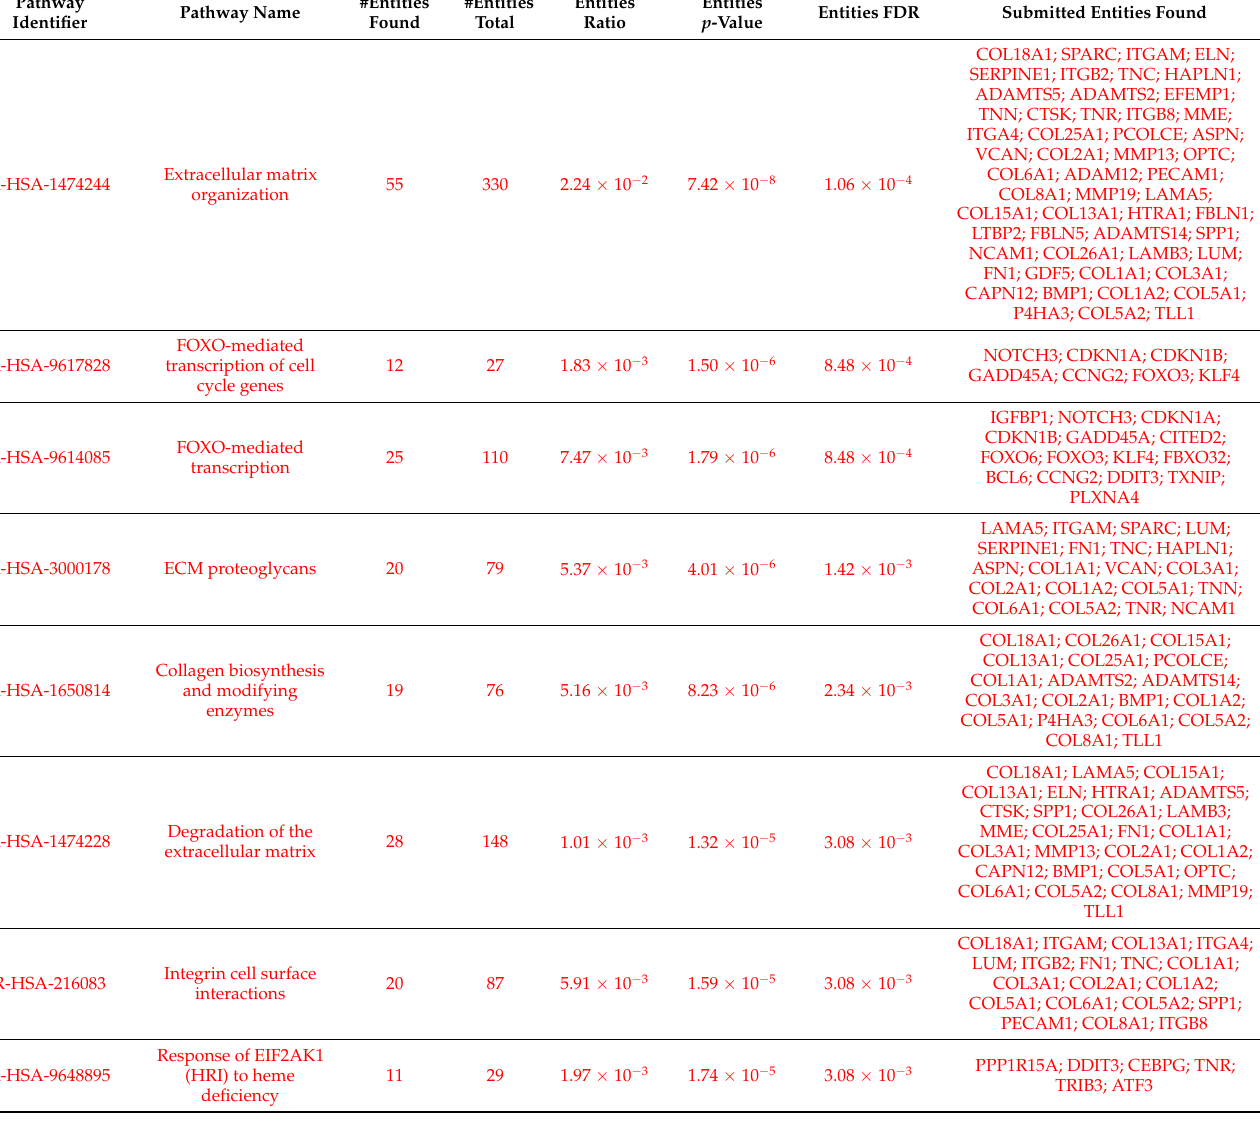
Table 2. The top 15 pathways enriched from the OA-responsive DEGs in female cartilage. Note: all pathways in the list have an FDR value less than